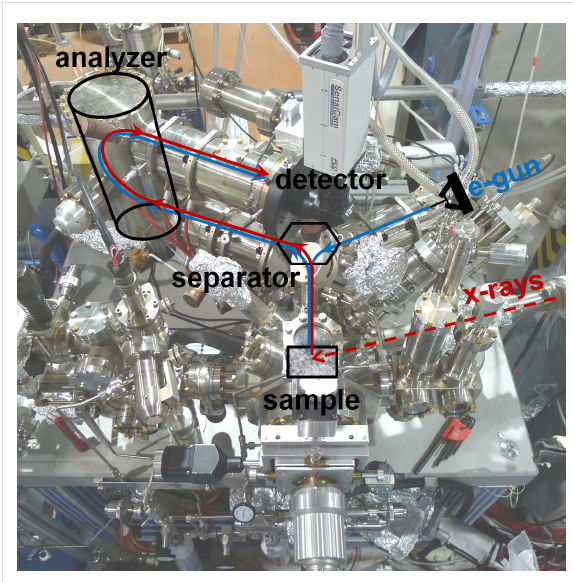
Figure 4: The SPELEEM instrument at the Nanospectroscopy beam- line, Elettra Sincrotrone, Trieste. The sketch of the basic setup is superimposed onto the photograph. X-rays arrive from the right at 16° grazing angle to the sample surface.